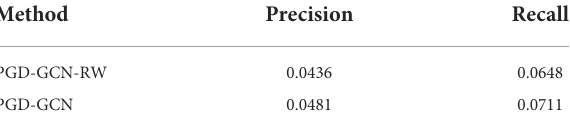
TABLE 8 Results of variants on Yelp.